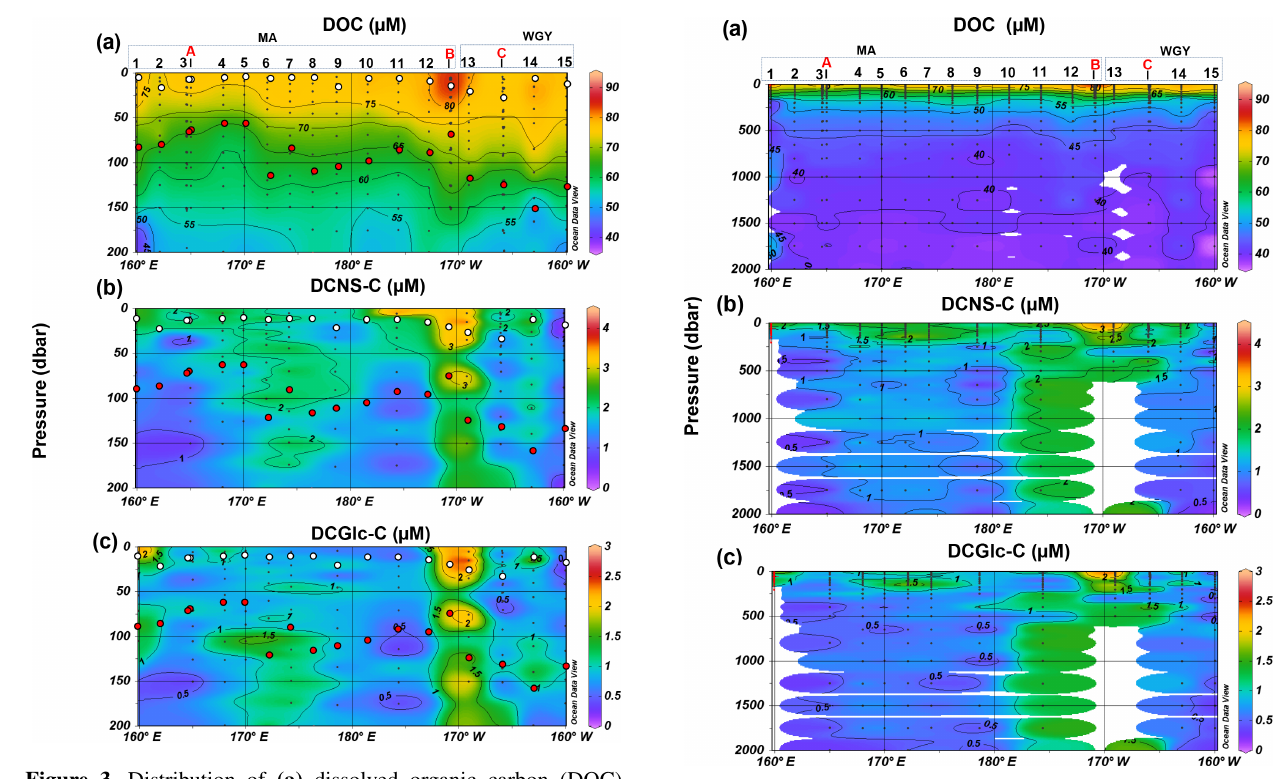
Figure 4. Depth profiles of (a) DOC, (b) DCNS and (c) DCGlc in the 0–2000m layer of the study area. DCNS and DCGlc concentra- tion is given in carbon equivalents in order to have the same unit as